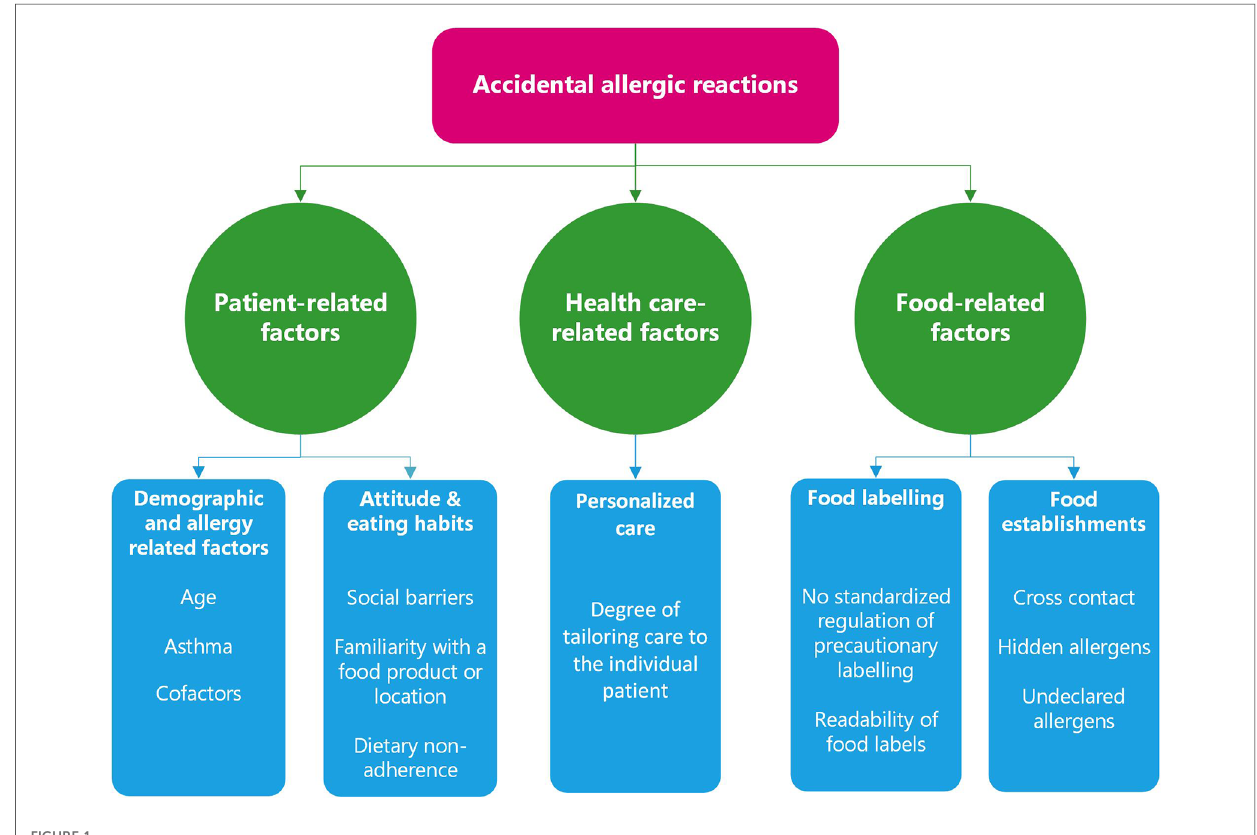
FIGURE 1 Factors affecting the occurrence of accidental allergic